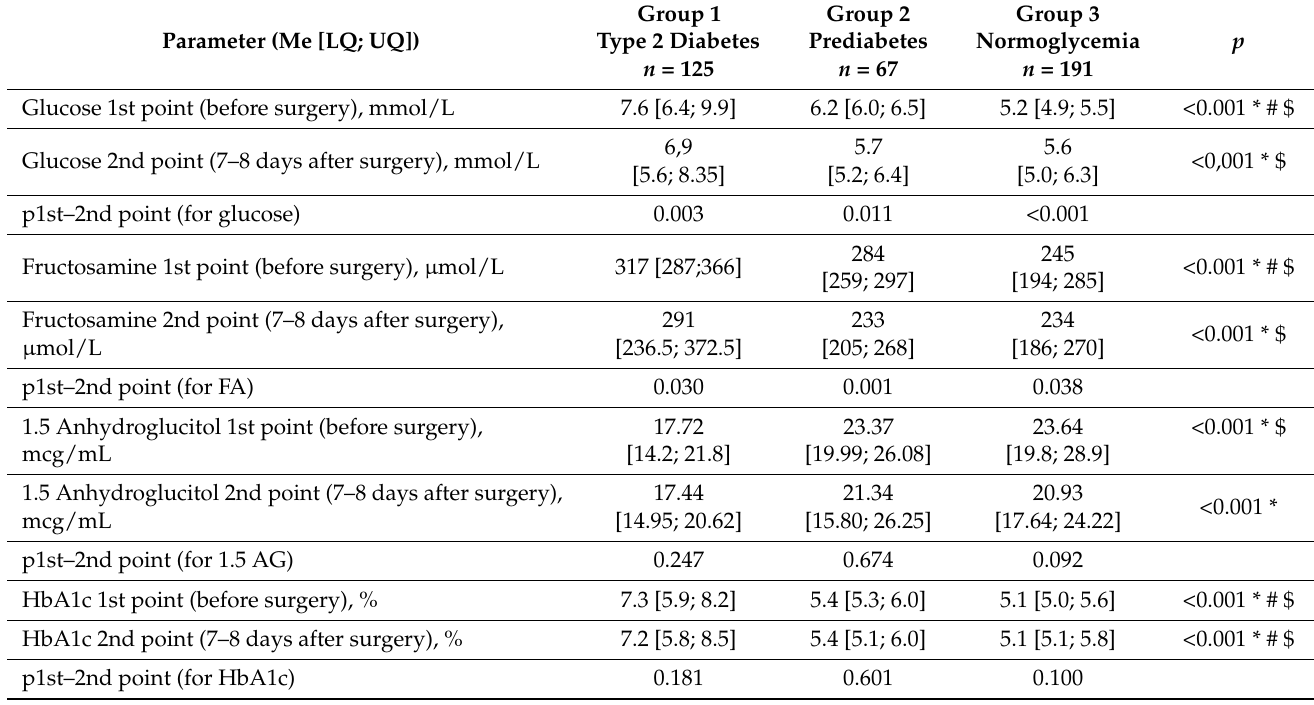
Table 3. The values of fructosamine, 1,5-anhydroglucitol, and glucose in groups and their periopera- tive dynamics ( n =